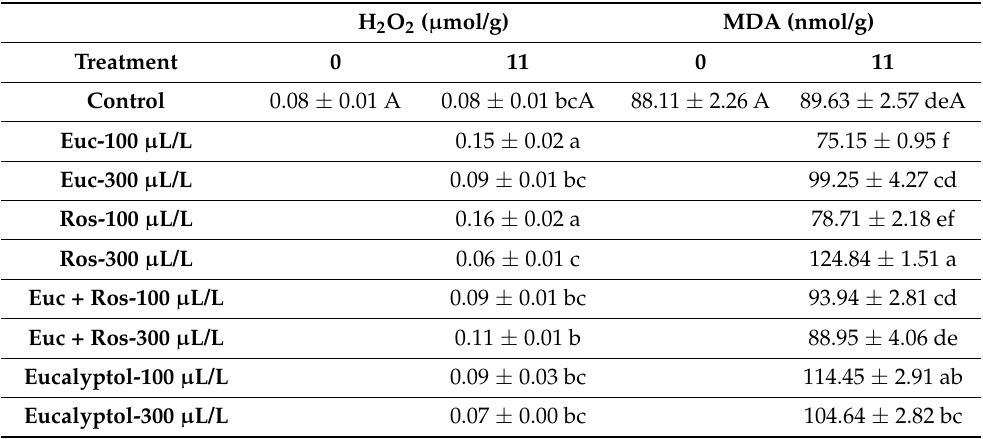
Table 5. Effects of eucalyptus EO (Euc), rosemary EO (Ros), their 50:50 mixture (Euc + Ros) and eucalyptol on damage index (H 2 O 2 and MDA) of inoculated with P. expansum pear fruits stored at 7 ◦ C for 5 days and subsequently at RT up to 11